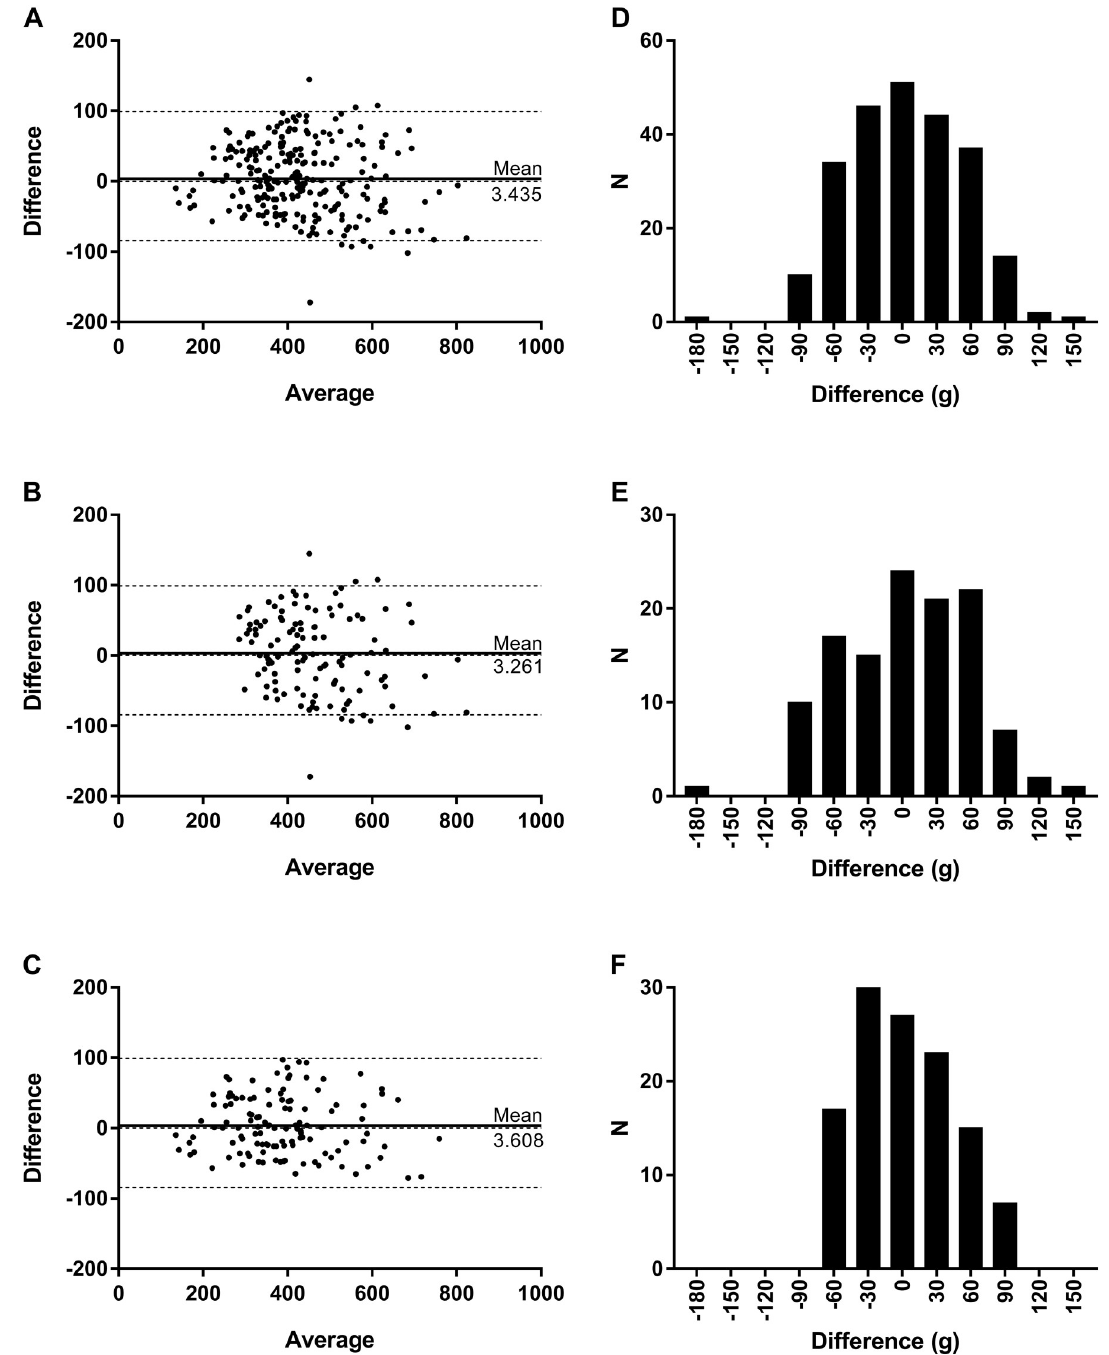
Fig 4. Device-standard agreement for Samsung Gear Fit2. (A-C) Bland-Altman plots of average versus difference for perspiration measurements of DBM Samsung Gear Fit2 (g) compared against participant weight change (g) for (A) all participants, (B) men, and (C) women. Solid line, line of equality; dotted lines, upper and lower bounds of 95%CI of the line of equality. (D-E) Frequency distribution histograms of method measurement differences (g) for (D) all participants, (E) men, and (F) women.